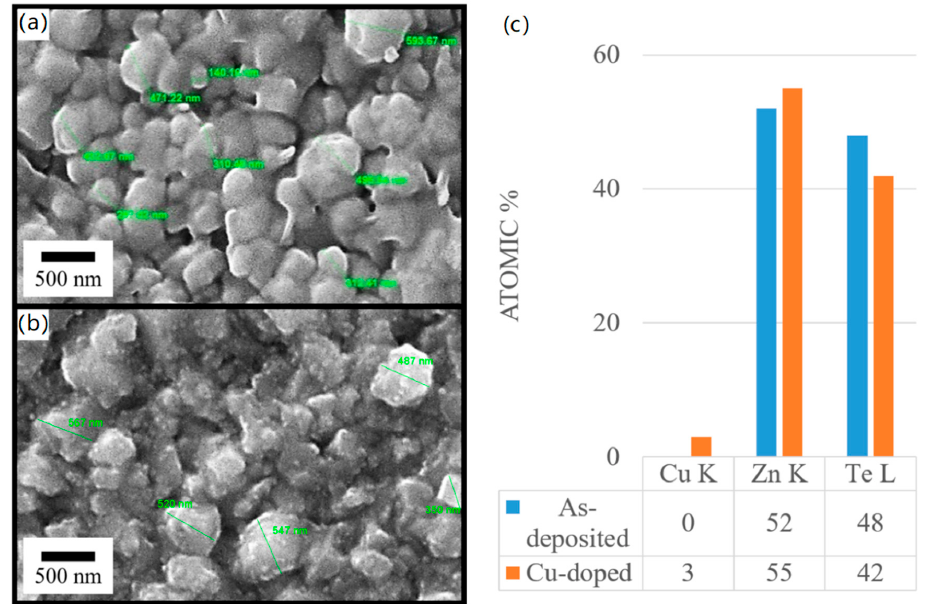
Figure 4. Scanning Electron Micrographs of ( a ) un-doped and ( b ) Cu-doped ZnTe thin film samples with ( c ) EDX analyses of un-doped and Cu-doped ZnTe thin film samples shows a Cu content of 3 at.% in Cu-doped